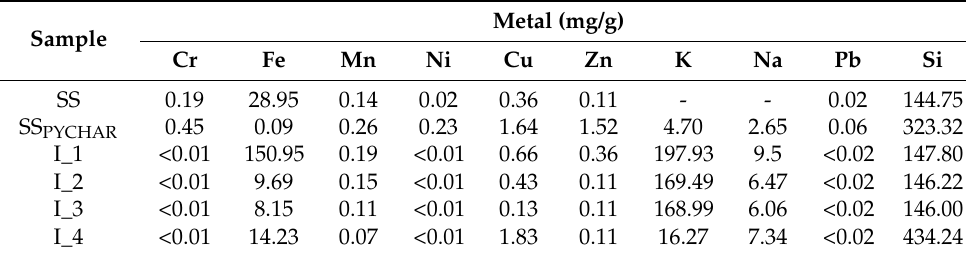
Table 3. The elemental content of the obtained